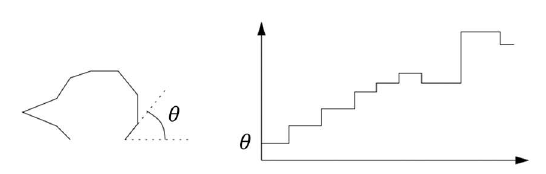
Fig. 16 Curve and turning function